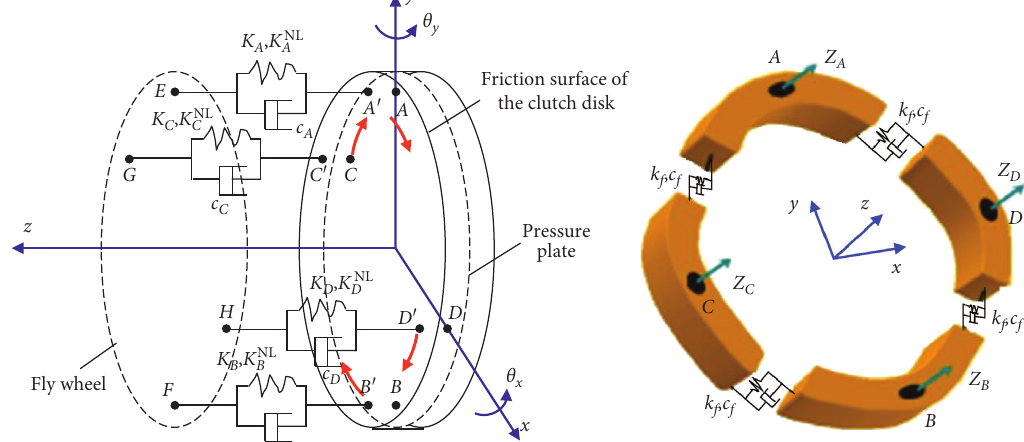
Figure 1: Squeal model of the clutch